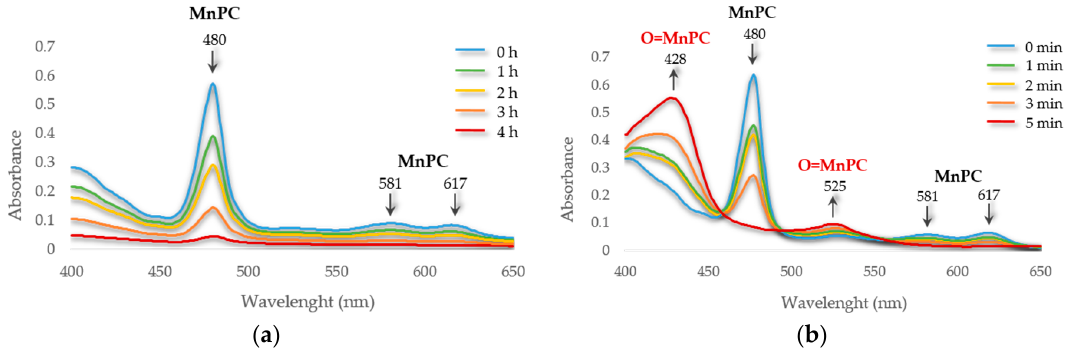
Figure 2. In situ UV-vis spectra of the manganese porphyrin cage catalyst MnPC during the aerobic epoxidation of cyclohexene: ( a ) in the presence of cyclohexene (cyclohexene (0.2 mmol), isobutyraldehyde (2.0 mmol), 4- tert -butyl-pyridine (1.0 mmol), MnPC catalyst (1.0 μ mol), DCE (4 mL), O 2 -balloon bubbling, 23 °C); ( b ) in the absence of cyclohexene (isobutyraldehyde (0.1 mmol), 4- tert -butyl-pyridine (0.5 mmol), MnPC catalyst (2.0 μ mol), DCE (4 mL), O 2 -balloon bubbling, 23 °C).